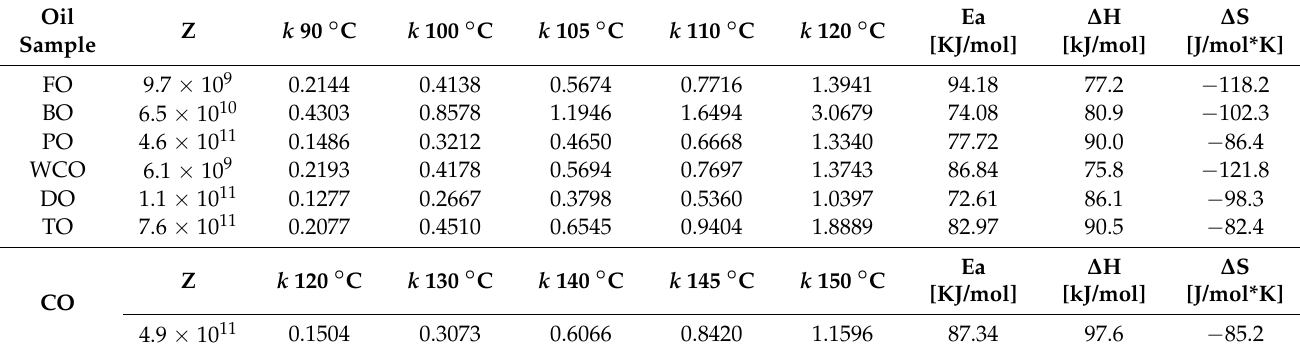
Table 5. Kinetics parameters of the analysed oils’ oxidation